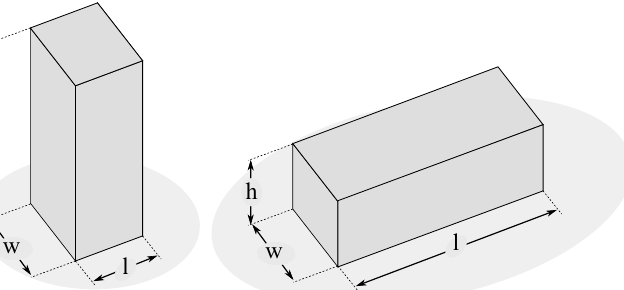
Figure 1. Schematics of the dimensions of short-depth-ratio ( left ) and large-depth-ratio ( right ) prisms.